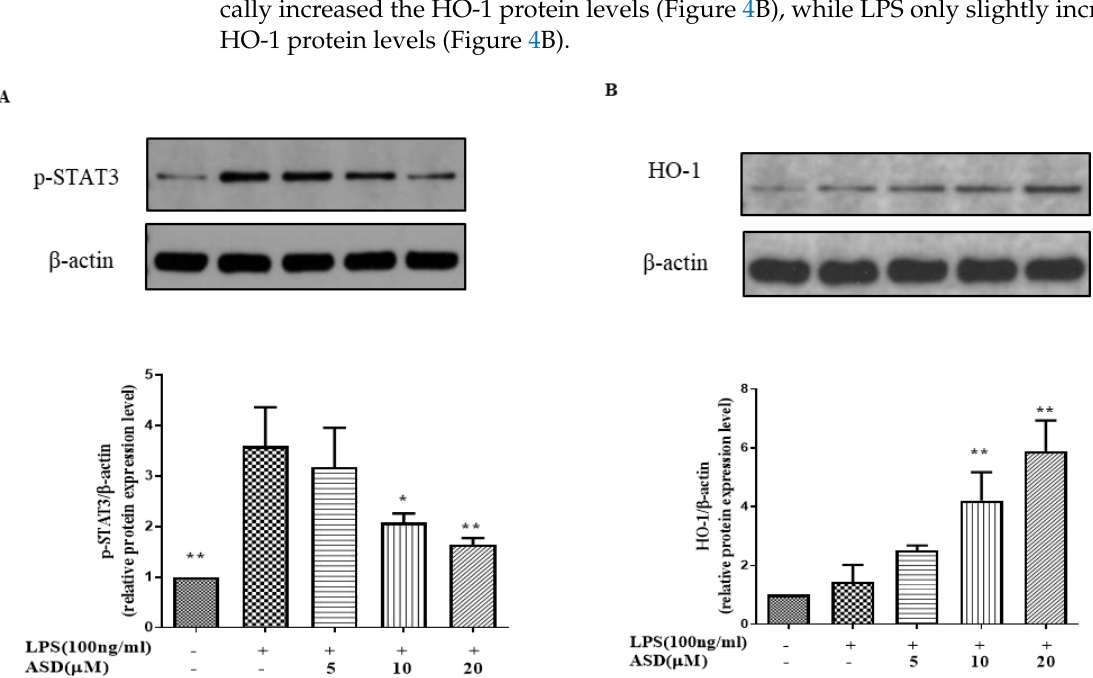
Figure 4. The effect of ASD on the protein levels of p-STAT3 and HO-1. Expression of p-STAT3 ( A ) and HO-1 ( B ). The data are shown as the average value ± SD, * p < 0.05, vs. LPS-treated cells, ** p < 0.01, vs. LPS-treated cells.